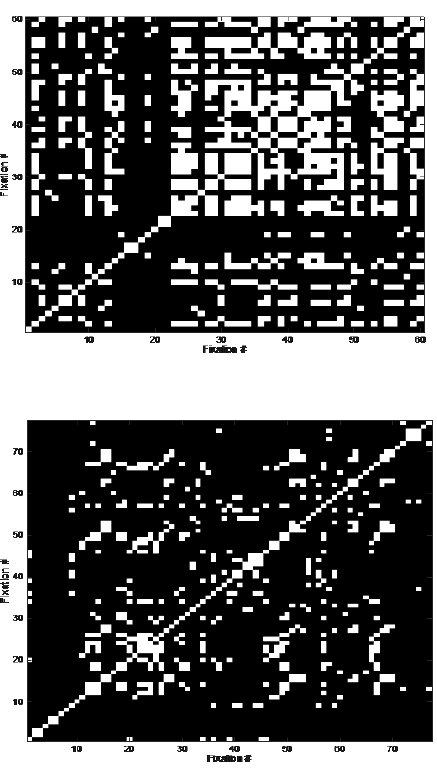
Figure 2 : The Recurrence plot generated by the rqa func- tion in Matlab ® for the closely-cropped renditions of the Flow- ers (top) and Clown (bottom) scenes. The Flowers scene is in the fifth row of the Still Life scenes in Figure 3 and the Clown scene is in the fourth row of the Interesting scenes. Note how fixations were highly concentrated on one area from fixation #23 through the end of the observation in the Flowers image. In the Clown image, note the diagonal line of fixations from (66,25) – (69,28). Although this image had a fairly low recur- rence value, its determinism value was relatively high.